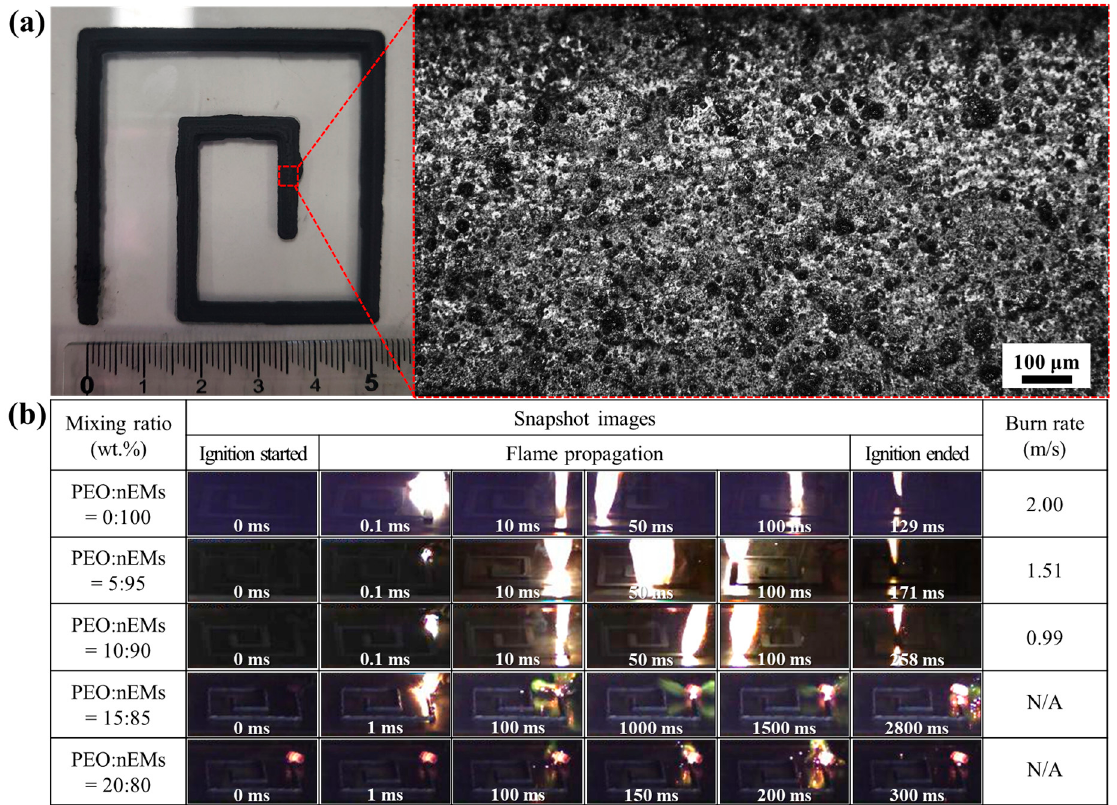
Figure 7. ( a ) Photograph and optical microscope images of 3D-printed serpentine pattern incorporated with PEO/nEM composites. ( b ) Images of the ignition and combustion flame propagation of PEO/nEM composite-based serpentine patterns. (The burn rates of PEO/nEM composites incorporated with >15 wt.% of PEO contents are not available due to the stopping of continuous fl ame propagation.).